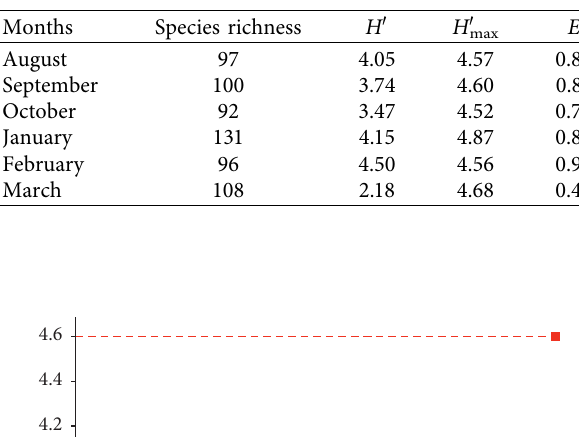
Figure 2: Few attractive bird species located in KSNP. (a) Pluvianus aegyptius . (b) Pterocles lichtensteinii . (c) Burhinus senegalensis . (d) Micronisus gabar . (e) Bubulcus ibis . (f) Ciconia episcopus . Table 2: Species richness, species evenness, and species diversity among the study months.